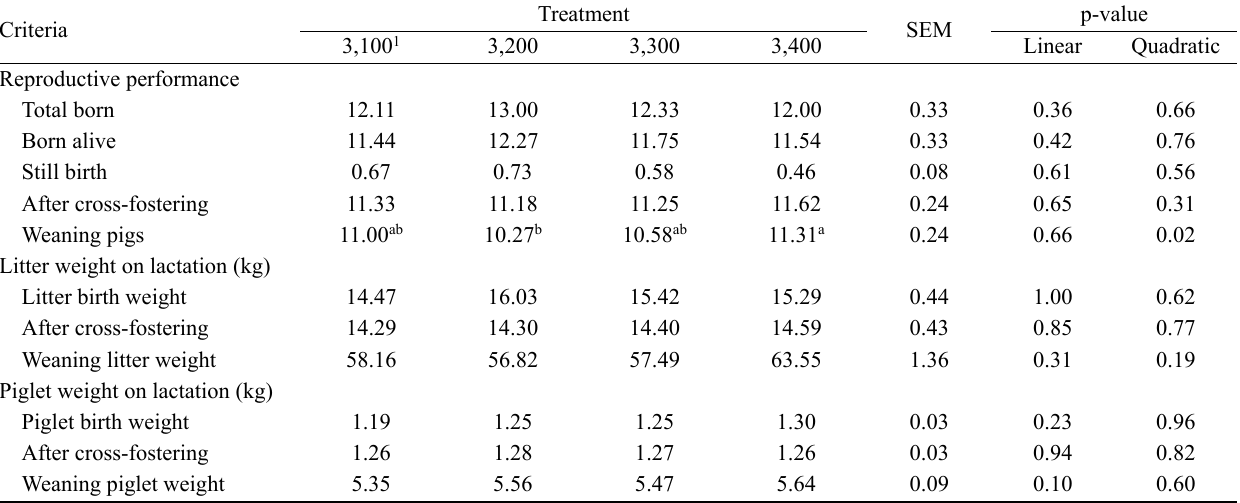
Table 4. Effects of the dietary energy level on the reproductive performance and growth of progeny of primiparous sows